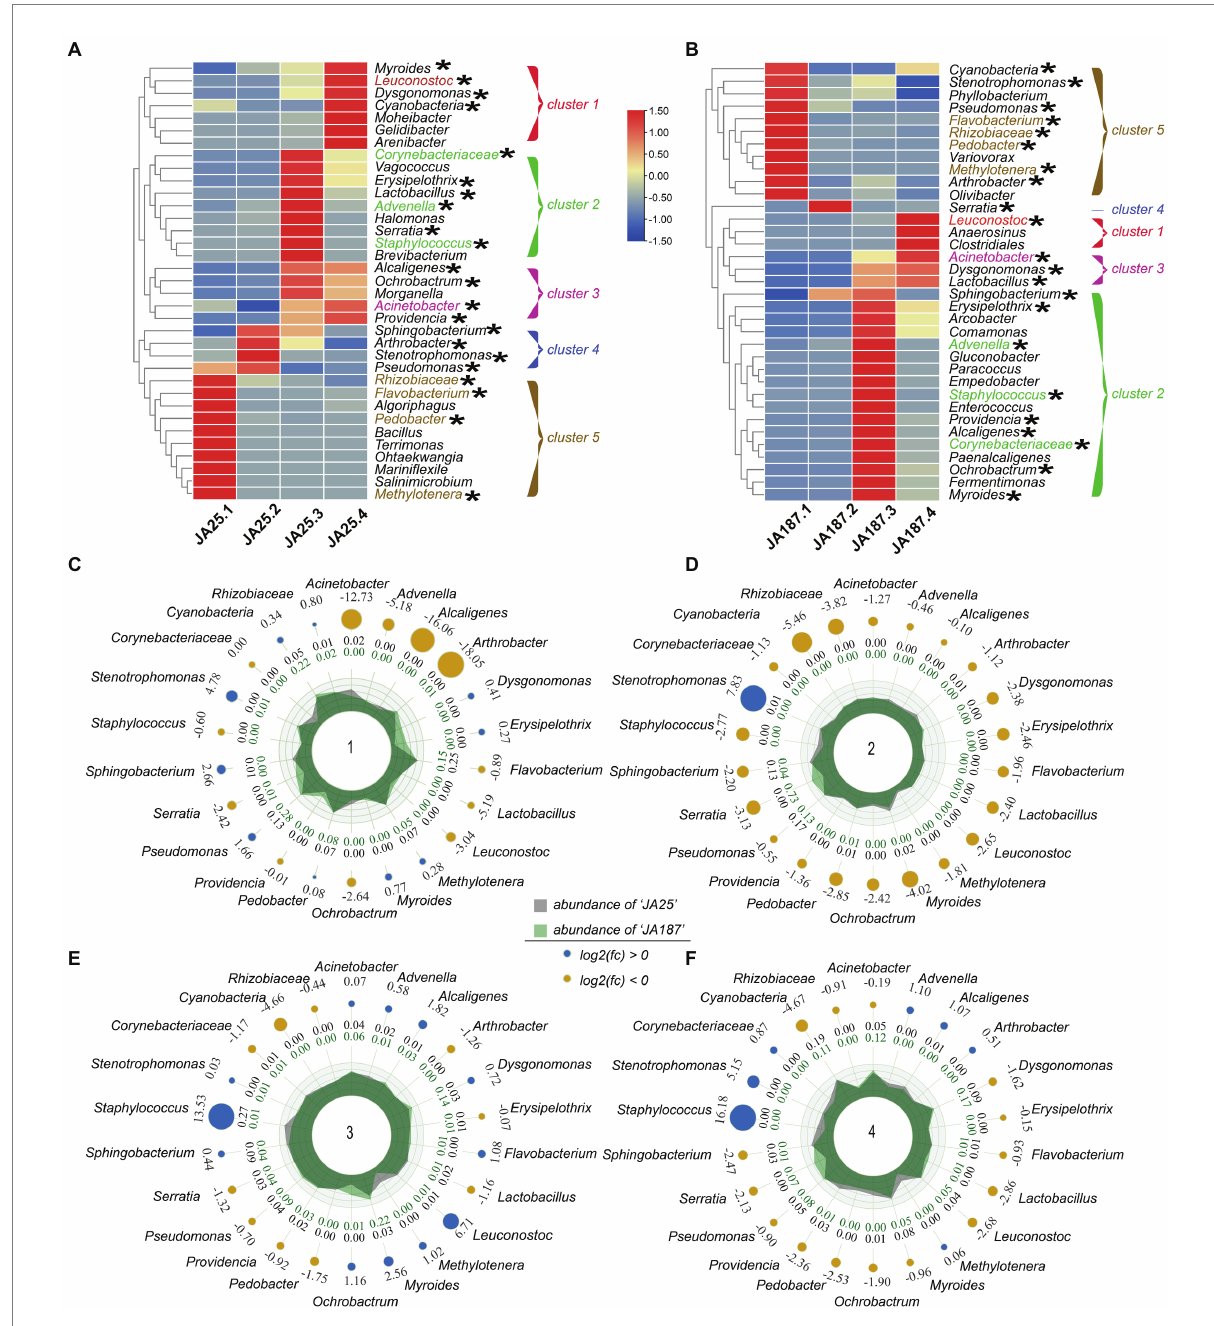
FIGURE 4 Dynamics of high-abundance bacteria in two Jerusalem artichoke resources during storage. ( A; ‘JA25’) and ( B; ‘JA187’) are the top 34 bacterial genus level Heatmap maps from the two resources, Cluster 1–5 indicates 5 bacterial clusters, with red and blue indicating high and low correlation, respectively. Radar plots show the abundance of a total of 22 bacteria from two chrysanthemum resources, with ( C–F ) representing four storage